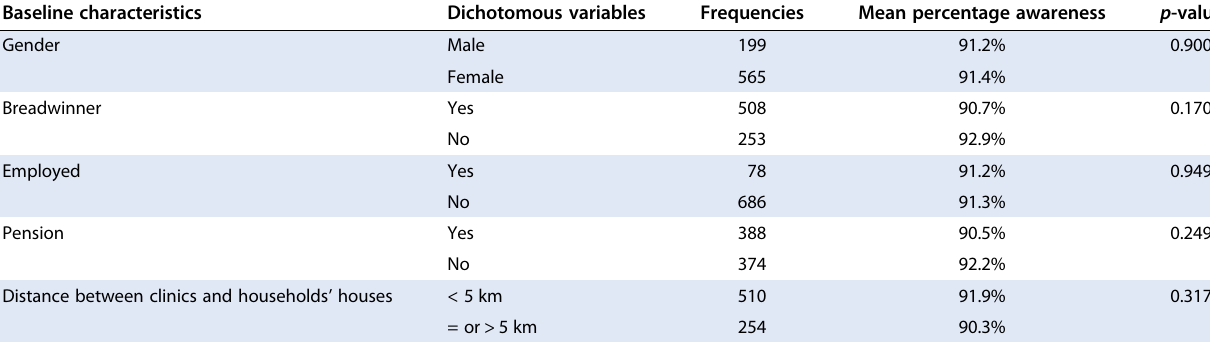
Table 3: Comparison of baseline characteristics with awareness of WBOT Baseline